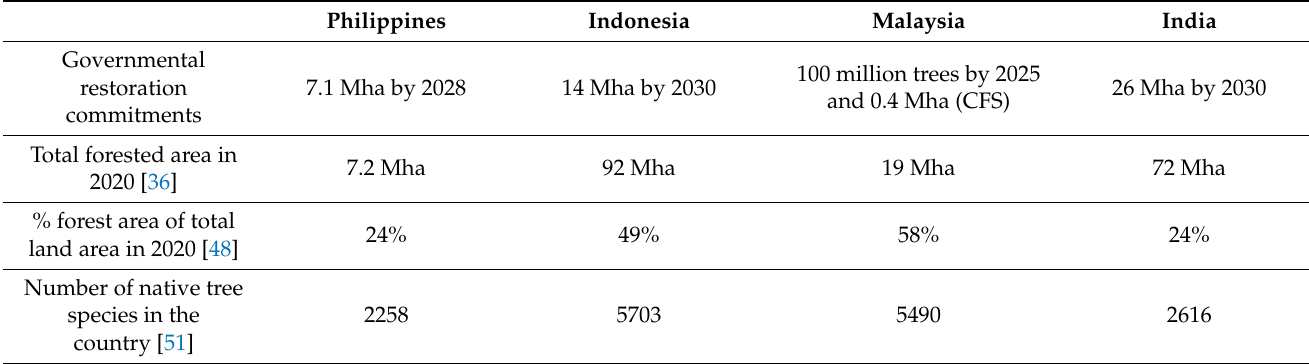
Table 1. Context for forest and landscape restoration commitments in the four analysed